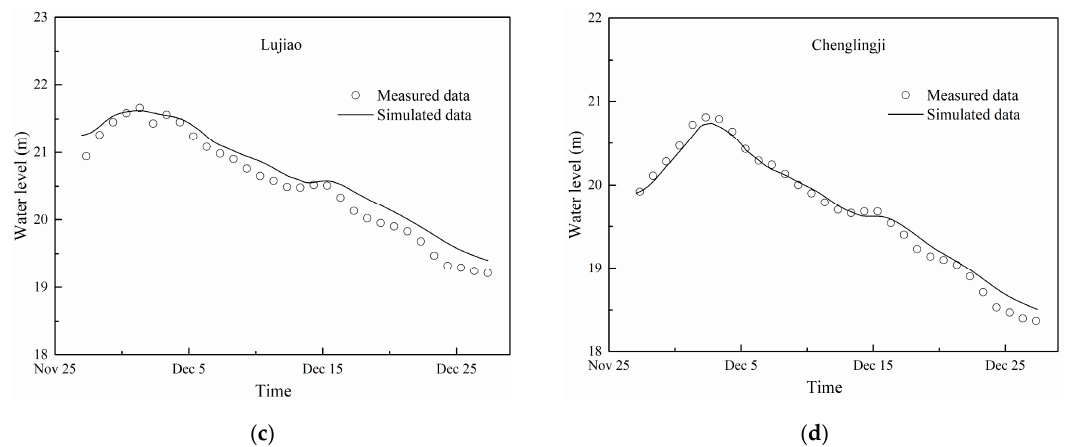
Figure 4. Comparison of water level process during the dry season (November to December) in 2006.